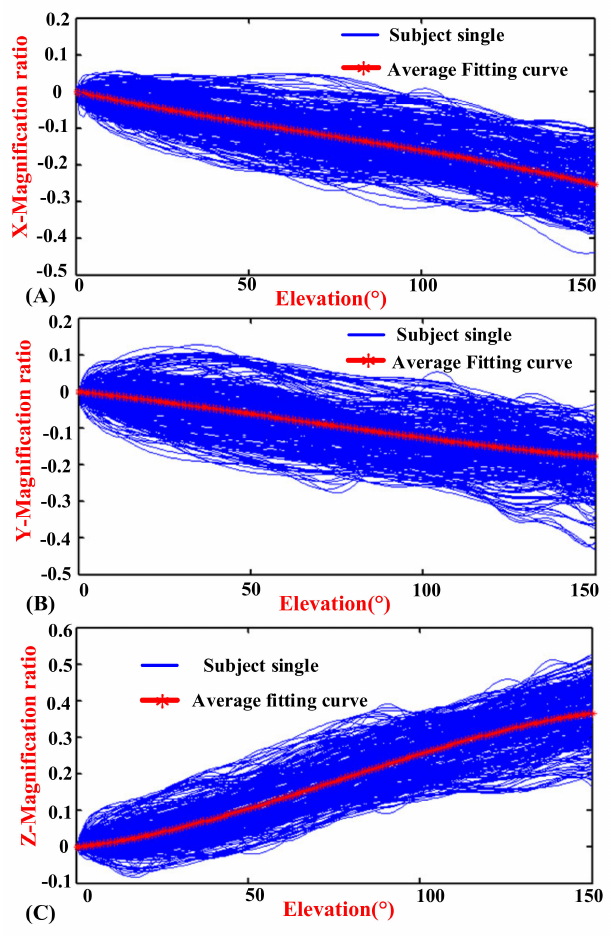
Figure 8. Diagrams of the magnification ratio of the GH joint center displacement variable quantity relative to the thorax coordinate system during humeral elevation in raising and lowering (RAL)